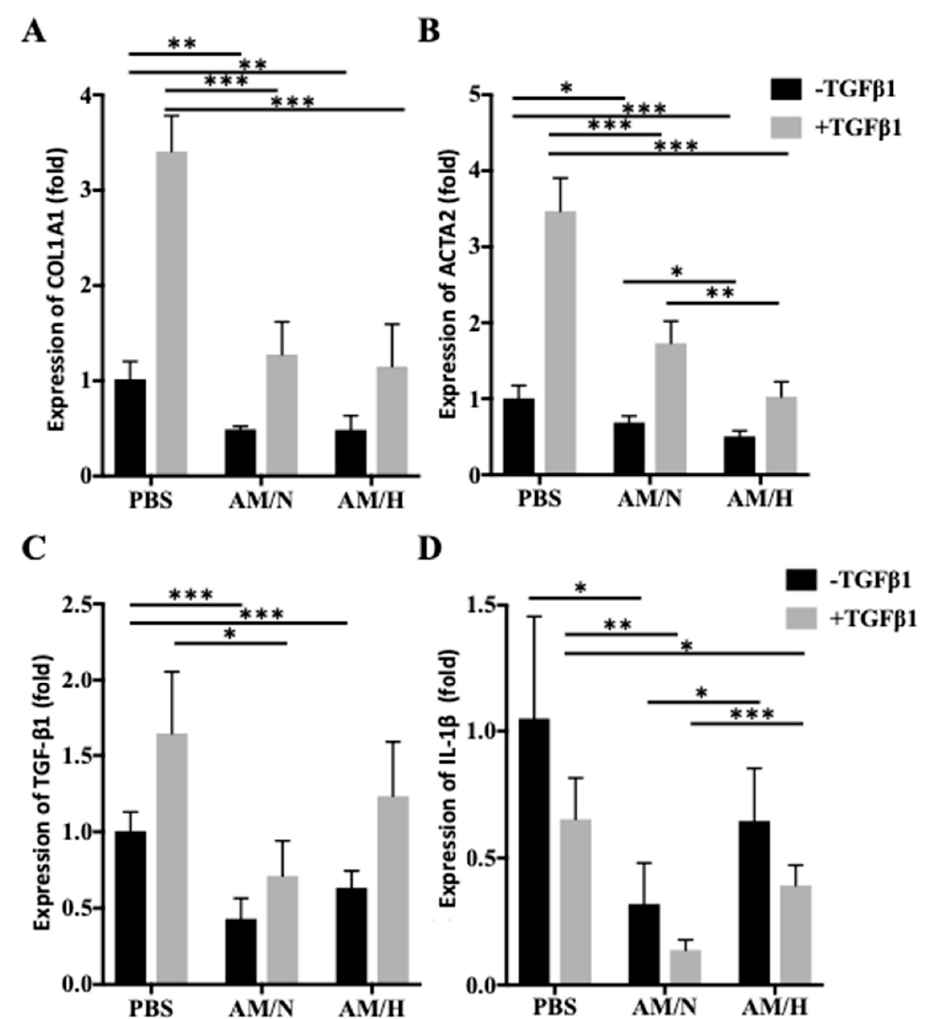
Figure 3. Effect of AM exosomes on the gene expression of fibrotic markers in LX-2 cells. Non-activated ( − TGF- β 1) and activated (+TGF- β 1) LX-2 cells were cultured in the presence or absence of AM exosomes for 2 days. Total RNA was isolated from LX-2 cells, and the relative expression of COL1A1 ( A ), ACTA2 ( B ), TGF- β 1 ( C ), and IL-1 β ( D ) was quantified by qPCR. The relative expression of each gene in the presence of exosomes was normalized to that of control (PBS (-TGF β -1)), which was set as 1. Data are presented as mean ± SD ( n = 4). * p < 0.05 ** p < 0.01 *** p < 0.005.